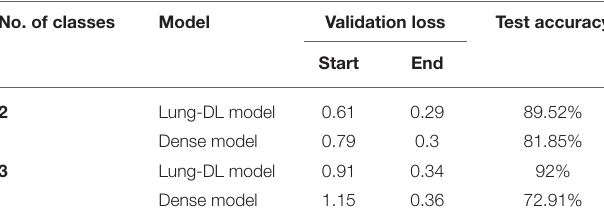
TABLE 2 | The performance comparison of different